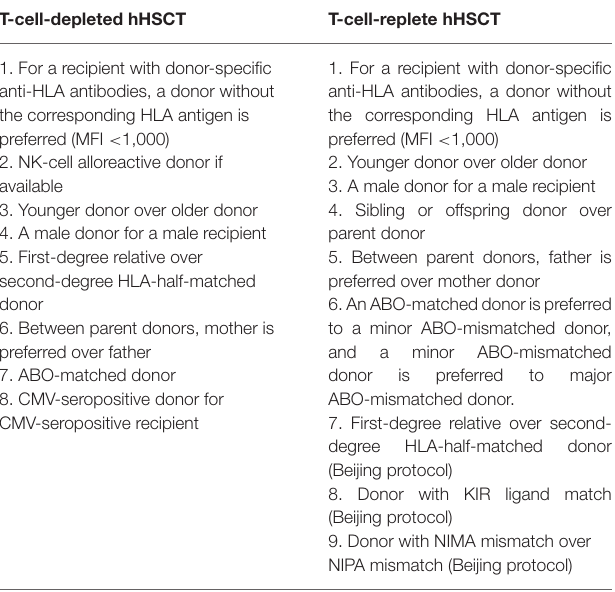
TABLE 2 | EBMT consensus recommendations for donor selection in hHSCT. T-cell-depleted